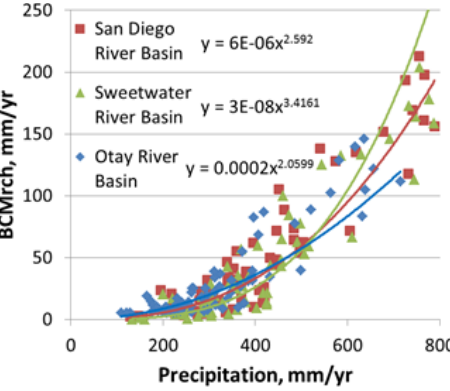
Fig. 10. Relation of BCM rch to precipitation for 1940–2009 for three river